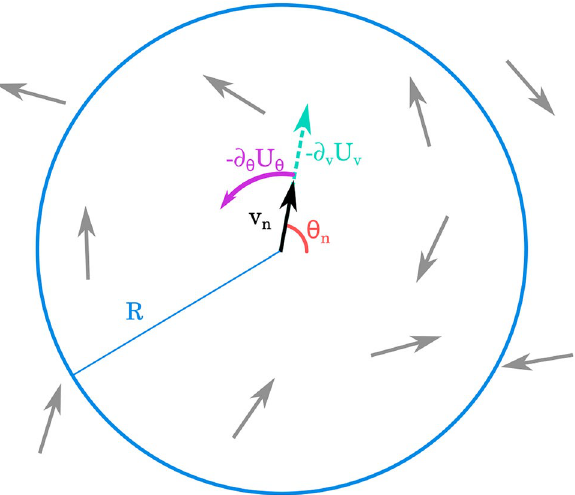
Figure 2. Graphic representation of the dynamics of the SPP model. The n -th cell is represented by a point particle with speed v n and orientation θ n . Depending on the form of the interaction potential, the cell may feel a reorientation force − ∂ θ U θ and a radial force − ∂ v U v due to interaction with other cells inside the interaction neighborhood defined by the radius R